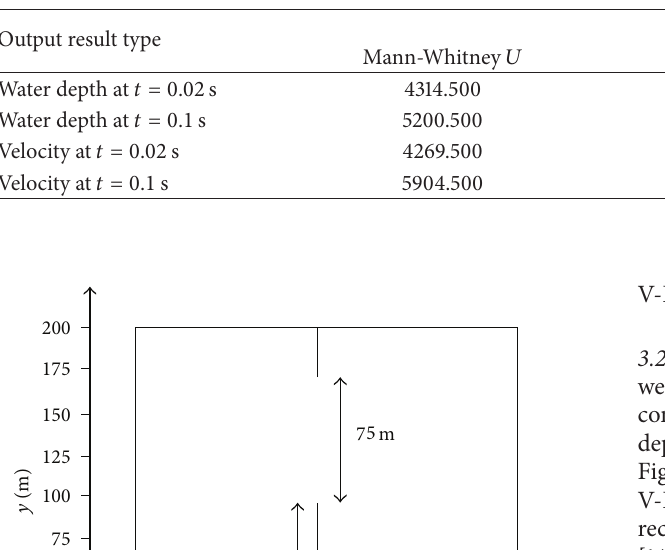
Table 2: Mann-Whitney test parameters for comparison between V-Break and stoker’s analytical solution results.